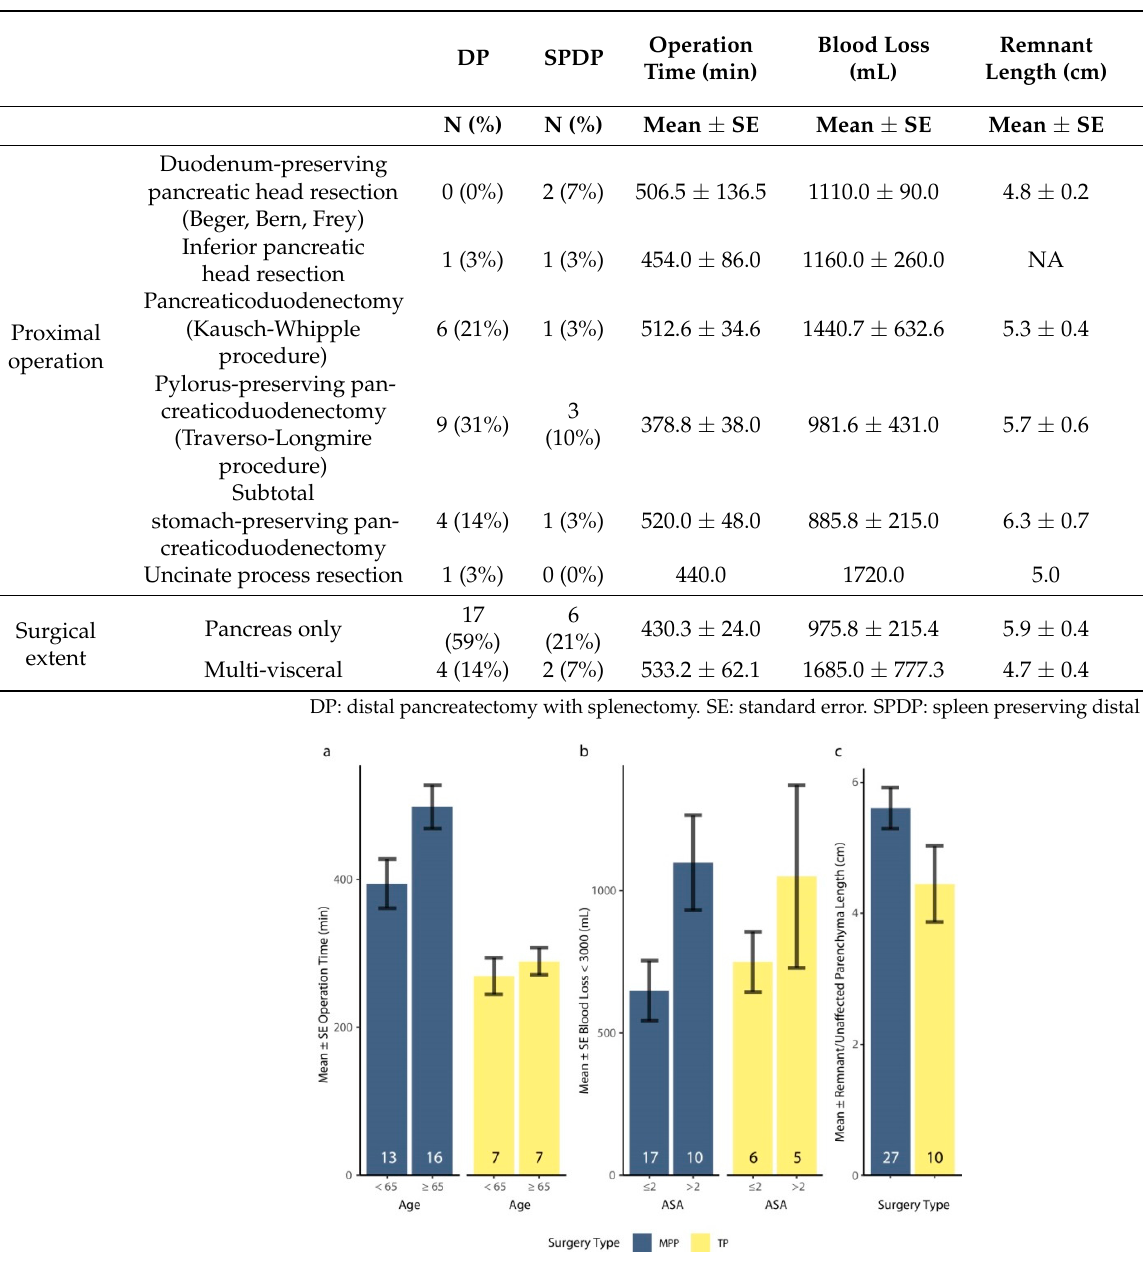
Table 2. Summary of intraoperative variables for MPP patients by proximal operation and surgical extent; frequency counts separated by use of spleen-resecting or -preserving procedures at the distal end.